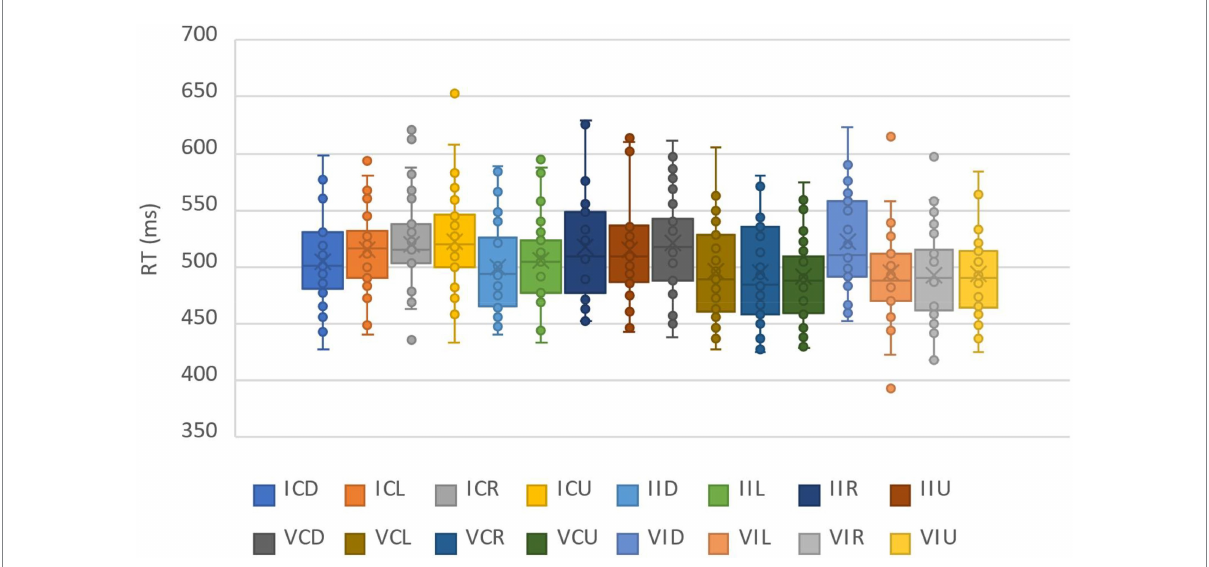
FIGURE 3 The data distribution of all participants under all conditions in Experiment 1. In the legend, the first capital letter represents the validity of the cue, I represents the invalidity of the cue, and V represents the validity of the cue. The second capital letter represents the semantic congruency of the cue and the target, C represents congruency, and I represents incongruency. The third capital letter represents the position of the cue, D represents down, L represents left, R represents right, and U represents up.